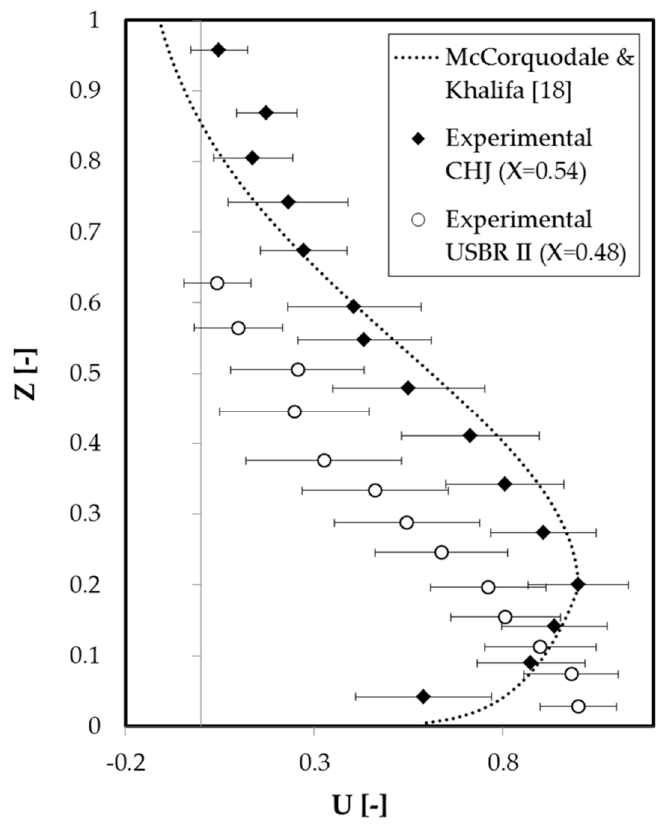
Figure 9. Streamwise velocity vertical profiles in the hydraulic jump for X ~0.5 and adjustment of the analytical expression for Classical Hydraulic Jumps (CHJ) by McCorquodale and Khalifa